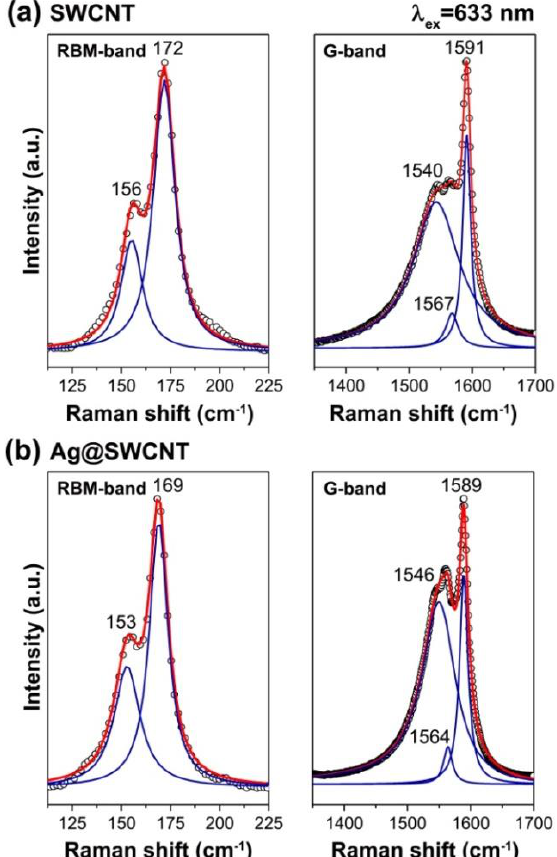
Figure 3. Raman spectra of the pristine SWCNTs ( a ) and silver-filled SWCNTs ( b ) recorded at 1.96 eV ( λ ex = 633 nm). The peak positions are indicated. Reproduced from M. V. Kharlamova et al. Donor doping of single-walled carbon nanotubes by filling of channels with silver, Journal of Experimental and Theoretical Physics, V. 115, № 3, p. 485 – 491, 2012, Springer Nature [110].